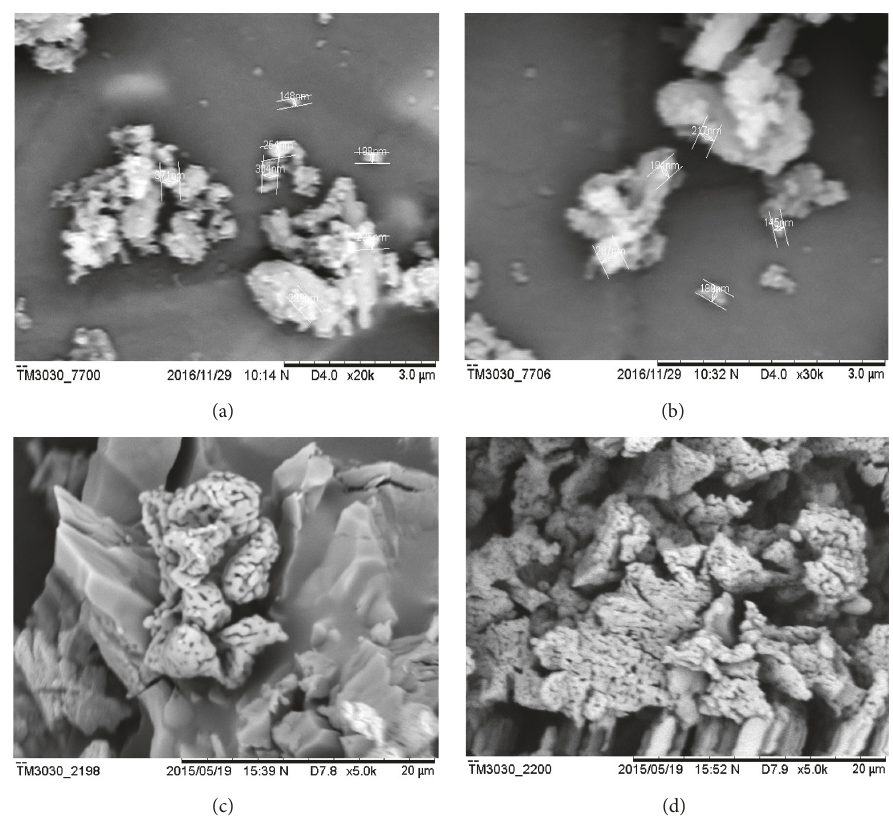
Figure 6: SEM monograms of (a, b) hydro aerated calcined Razor shell CaO; (c, d) calcined lab grade